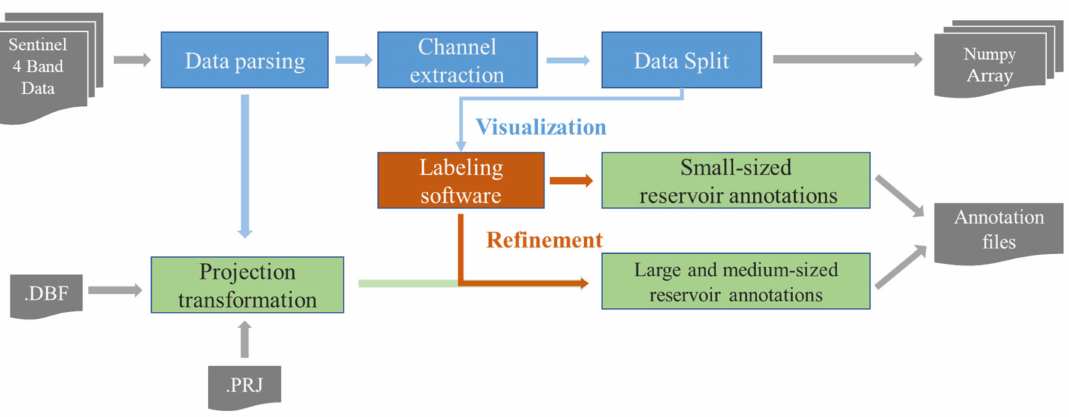
Figure 4. Acquisition of the annotations from the refinement of Large and medium-sized targets and manual annotation of small